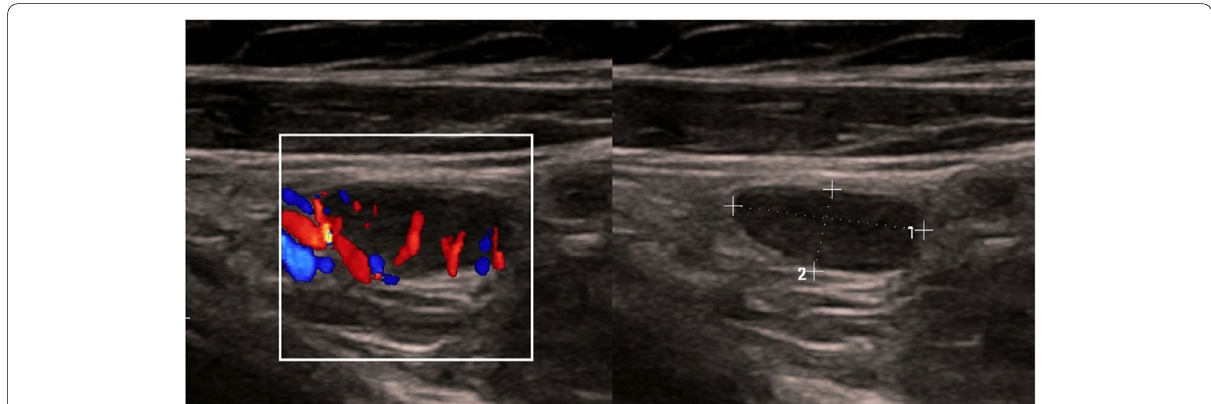
Fig. 2 Grayscale ultrasound of the neck shows abnormal‑looking lymph nodes evident by exaggerated hypoechoic echotexture and lost fatty hilum. The largest one 18 10 mm in ×